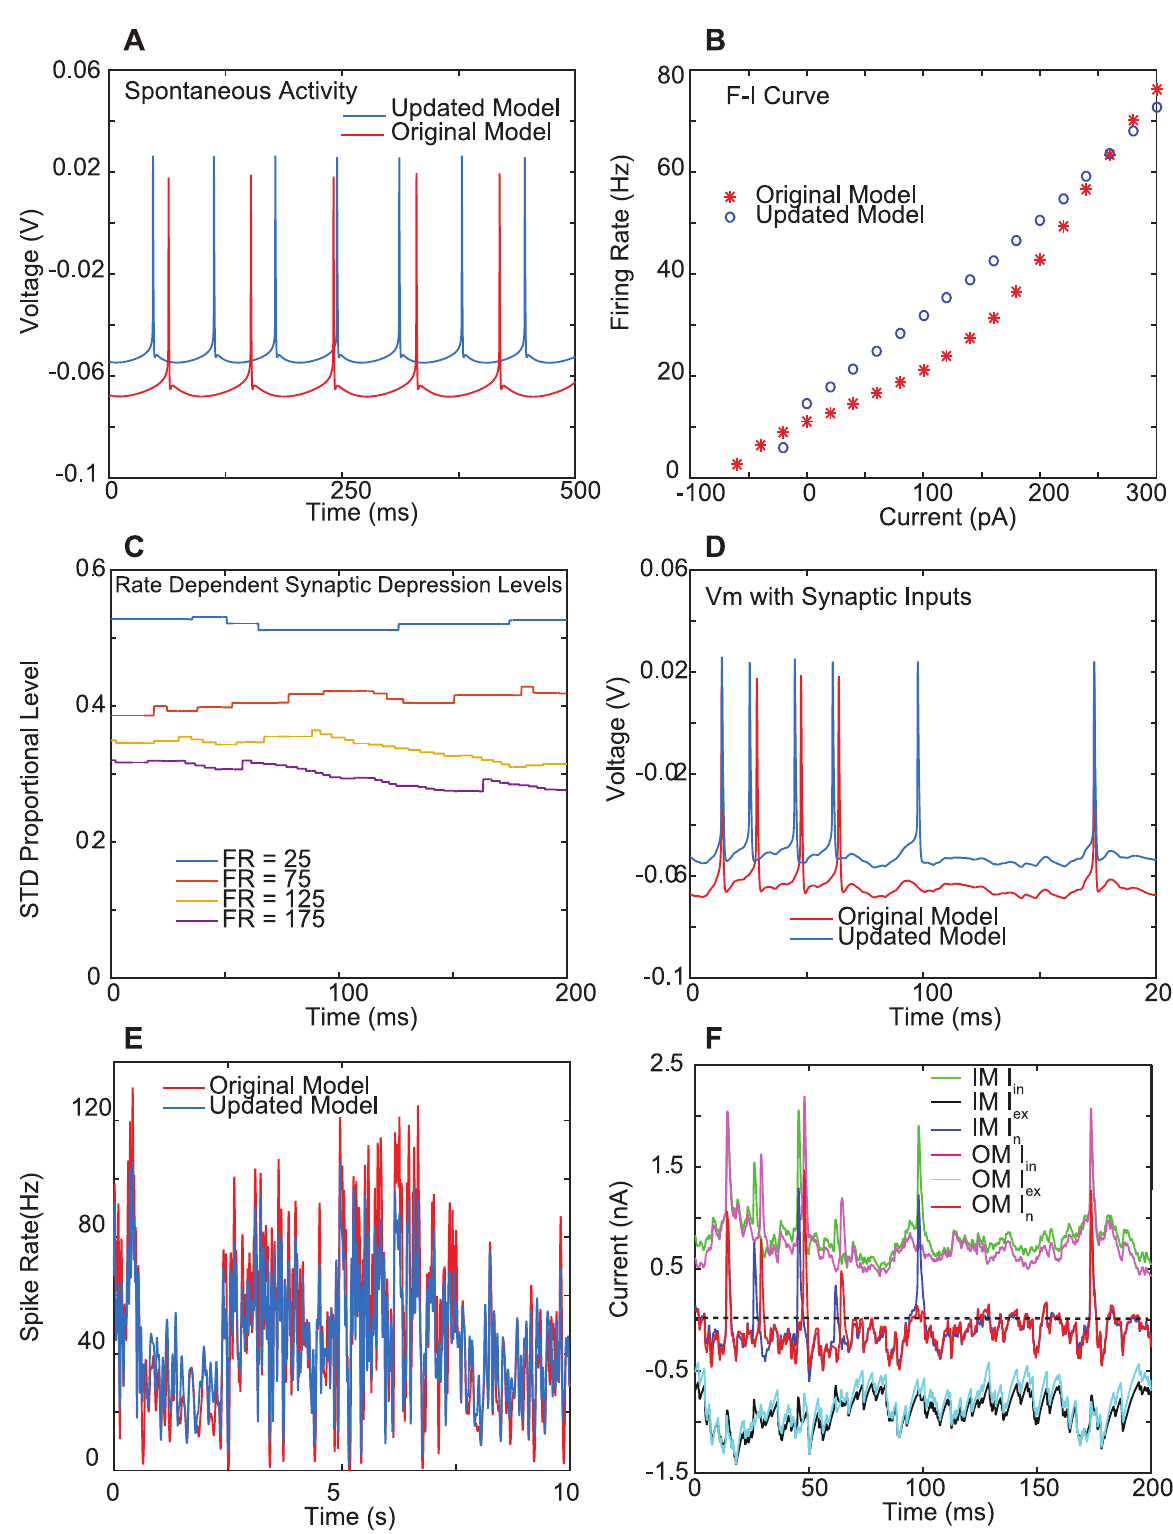
Fig 2. Properties of biophysical CN model. A. Spontaneousspiking in the absenceof synaptic input. The originalmodel is as published on ModelDB(https://senselab.med.yale.edu/modeldb/ShowModel.cshtml?model=136175), whilethe updatedmodel includes the changesdescribedin the Supplemental Materialsof the originalpublication[7]. B. The model spike rate as a function of injected